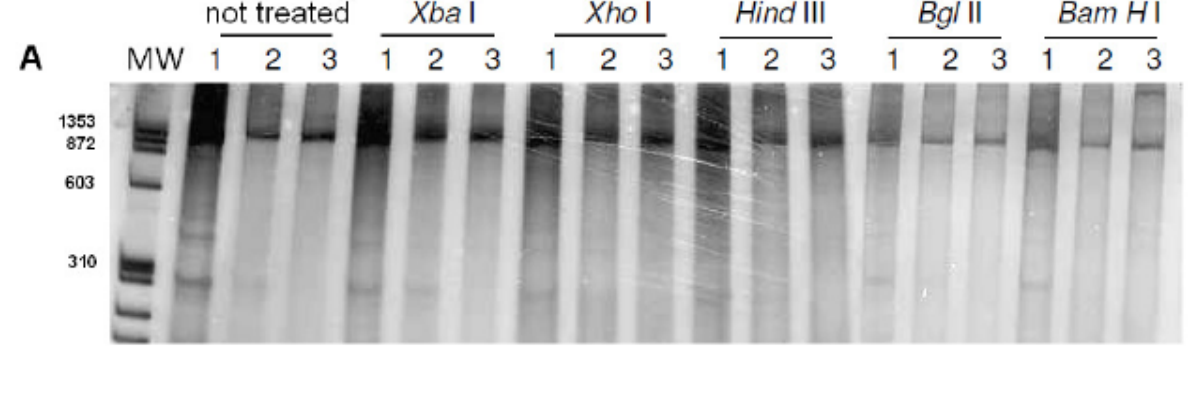
Figure 5. Polyacrylamide gel electrophoresis with silver stain. PCR-RFLP of the amplicons of the introns from Biomphalaria myoglobin. 1. B. glabrata ; 2. B. straminea ; 3. B. tenagophila . MW = molecular weight (base pairs) of  X174/ Hae III (Amersham Biosciences). Above the lanes, restriction endonucleases are